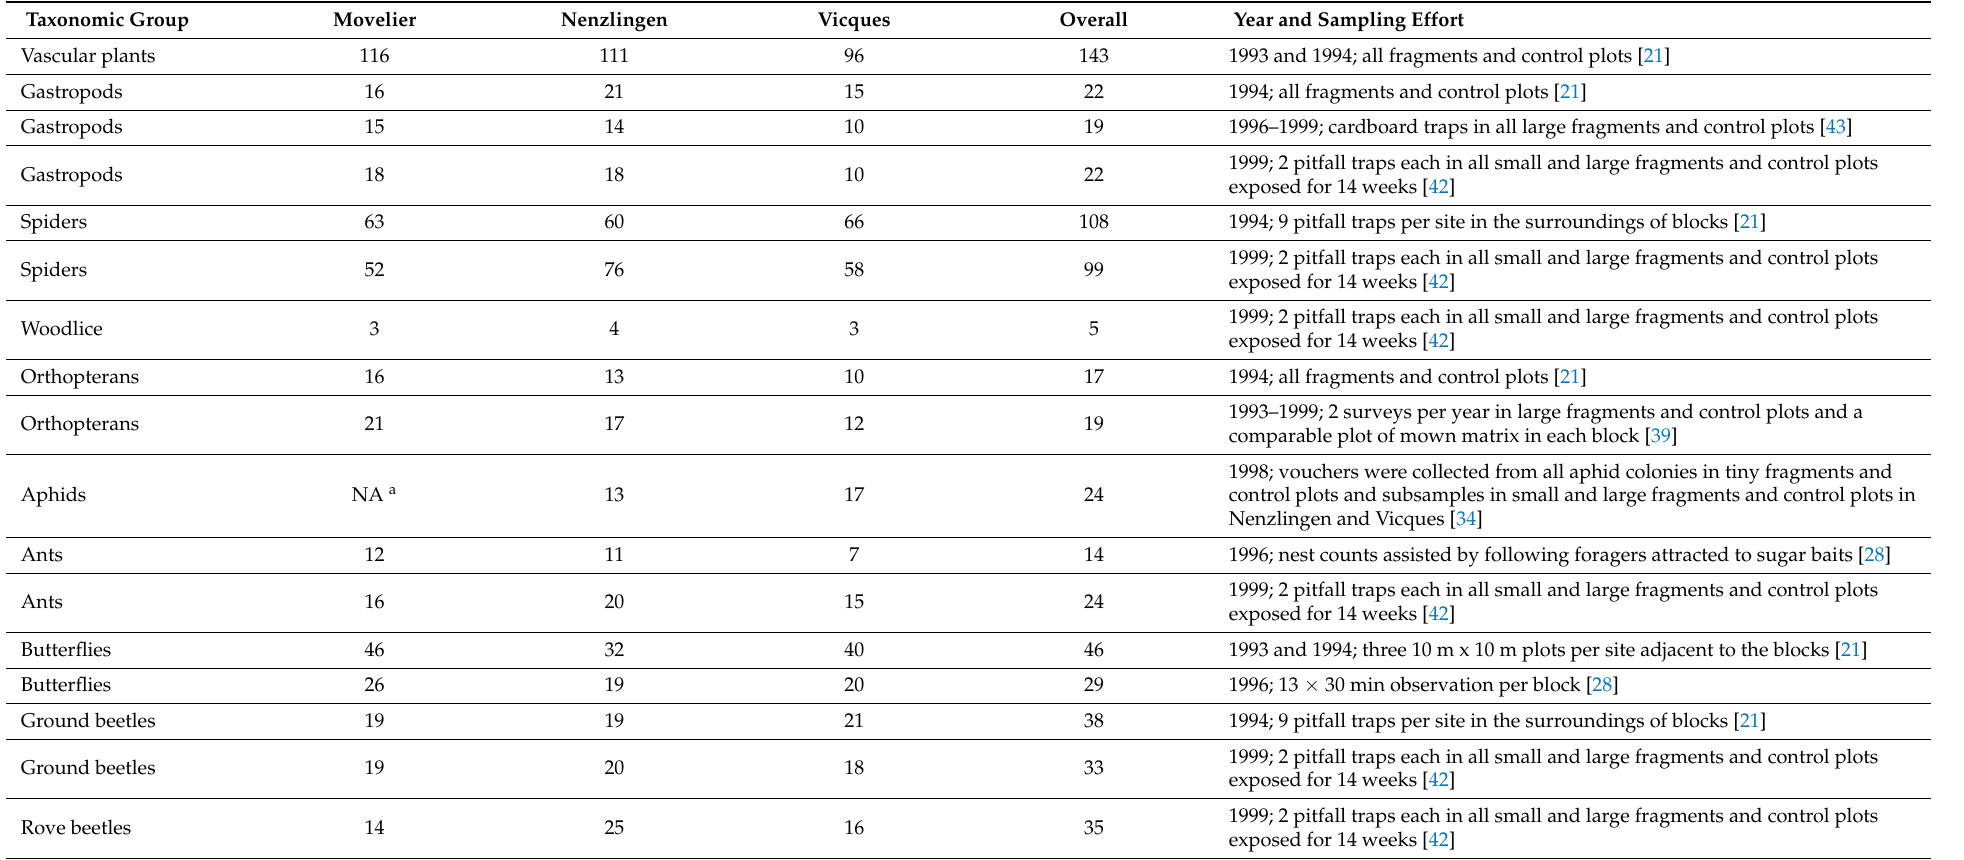
Table 3. Number of species recorded in various taxonomical groups in the three study sites (and overall). Some taxonomical groups were surveyed at different times during the experiment using different methods and are thus listed more than once. In a few groups, the number of species recorded was not reported in publications. In these cases, the figures are based on the raw data from those